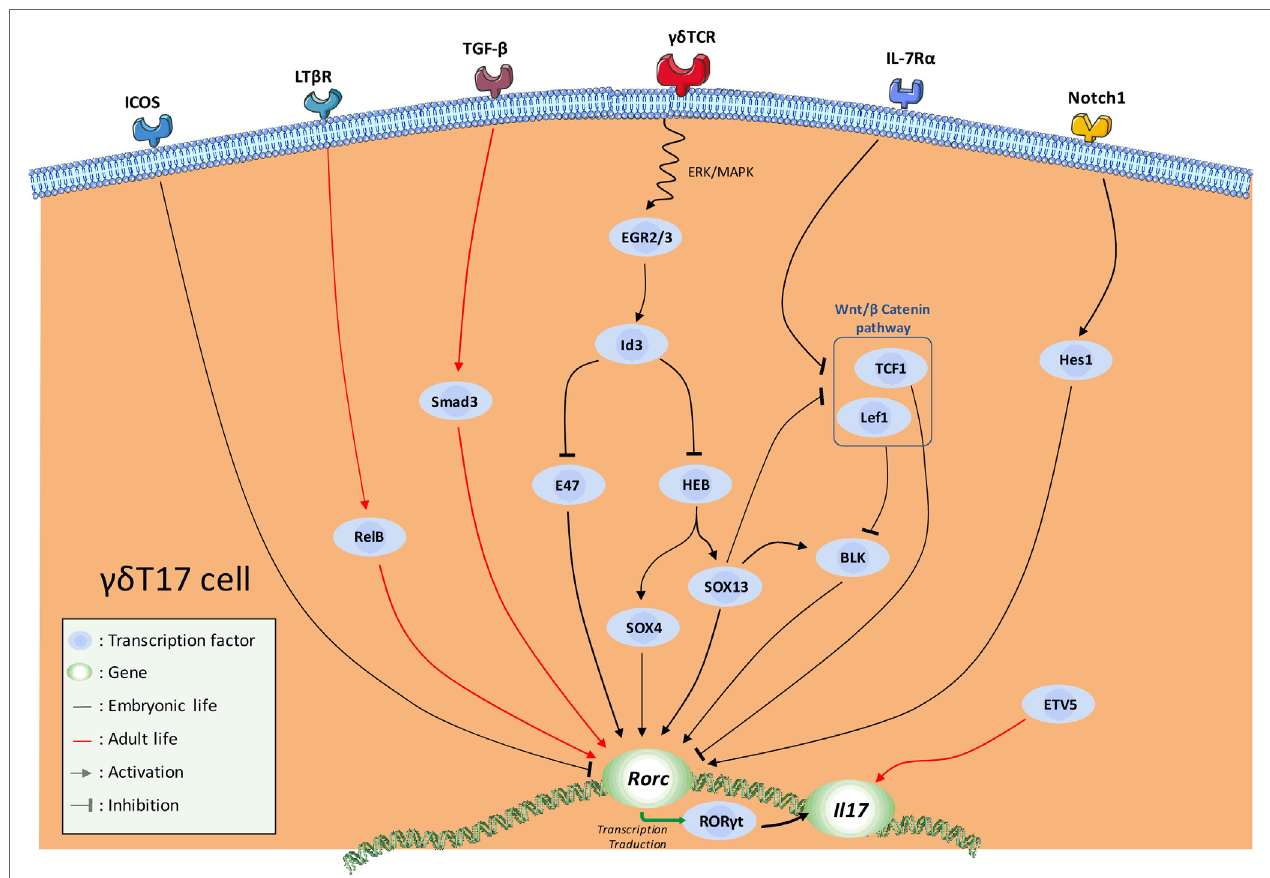
FiguRe 2 | Schematic overview of the current knowledge in the transcription factor (TF) network involved in natural γδ T17 cell effector fate. Major activating and repressing pathways implicated during γδ 17 effector fate acquisition are